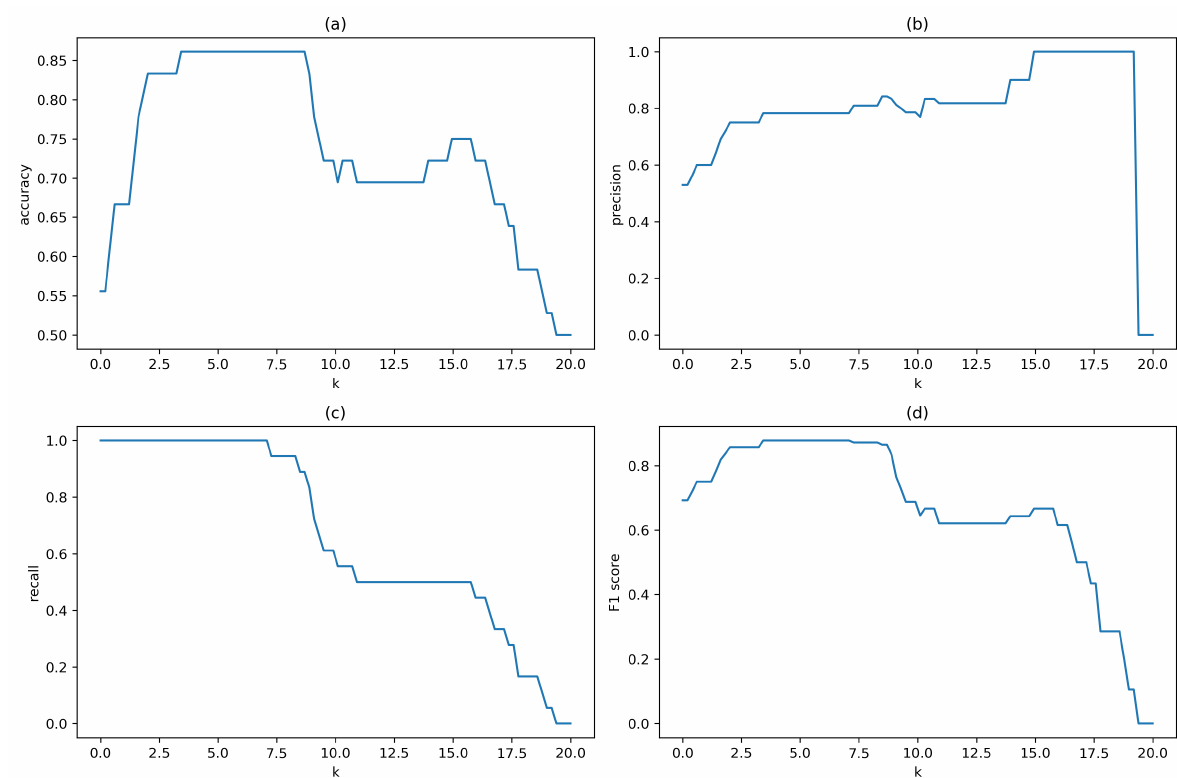
Figure 6. ( a ) accuracy, ( b ) precision, ( c ) recall and ( d ) F1 score graphs presenting classification performance of batch- processing motion detection in dependency of increasing threshold.